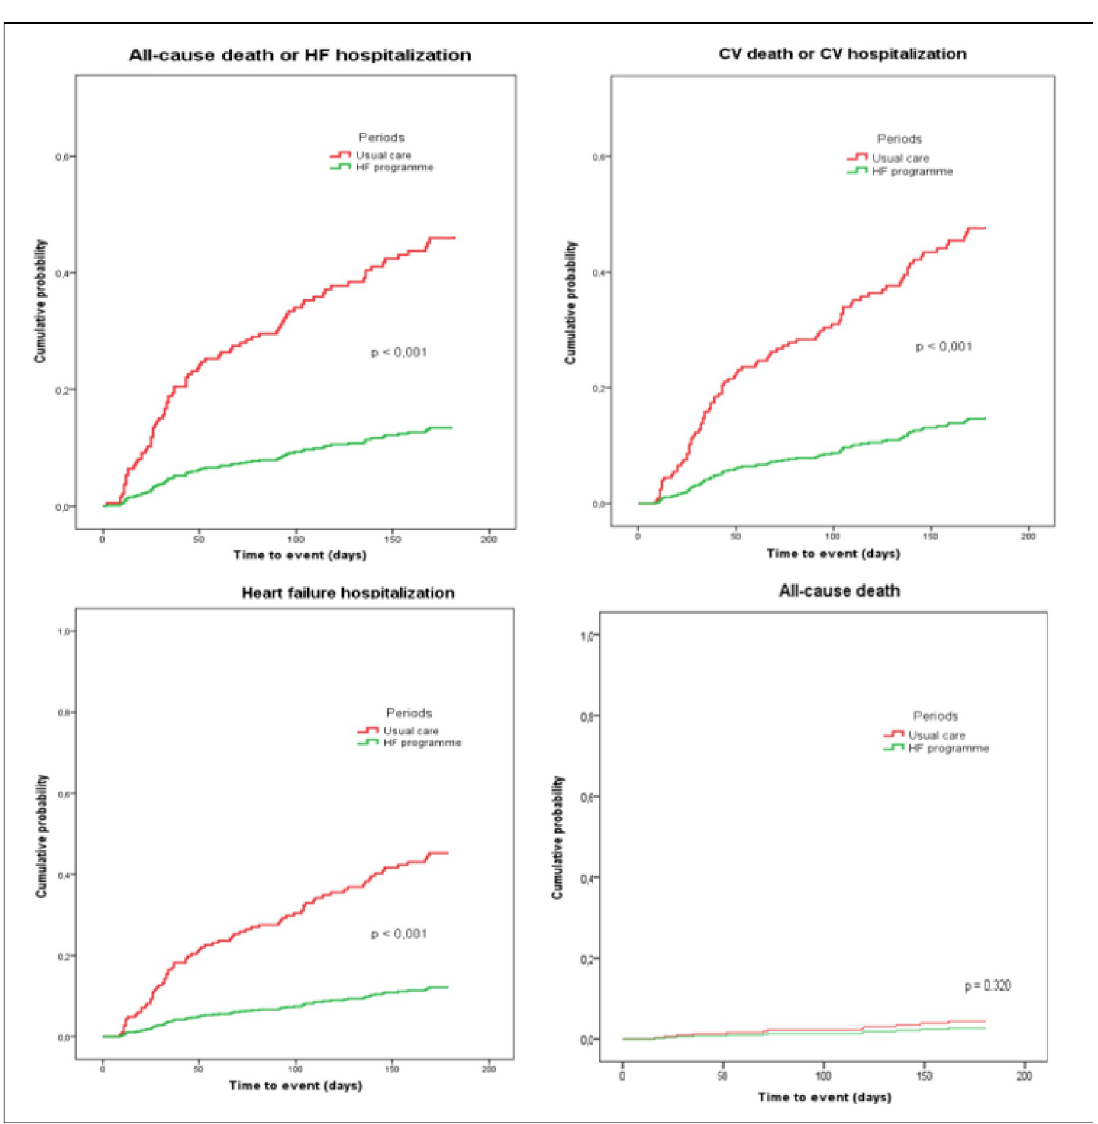
Fig 2. Adjusted time-to-event estimates for the secondary endpoints according to treatment